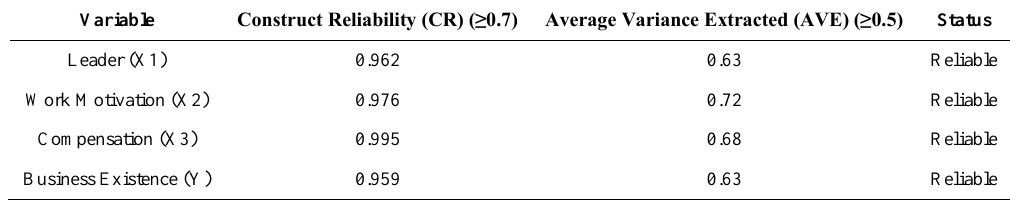
Table 2. Reliability Test Results and Average Variance Extracted